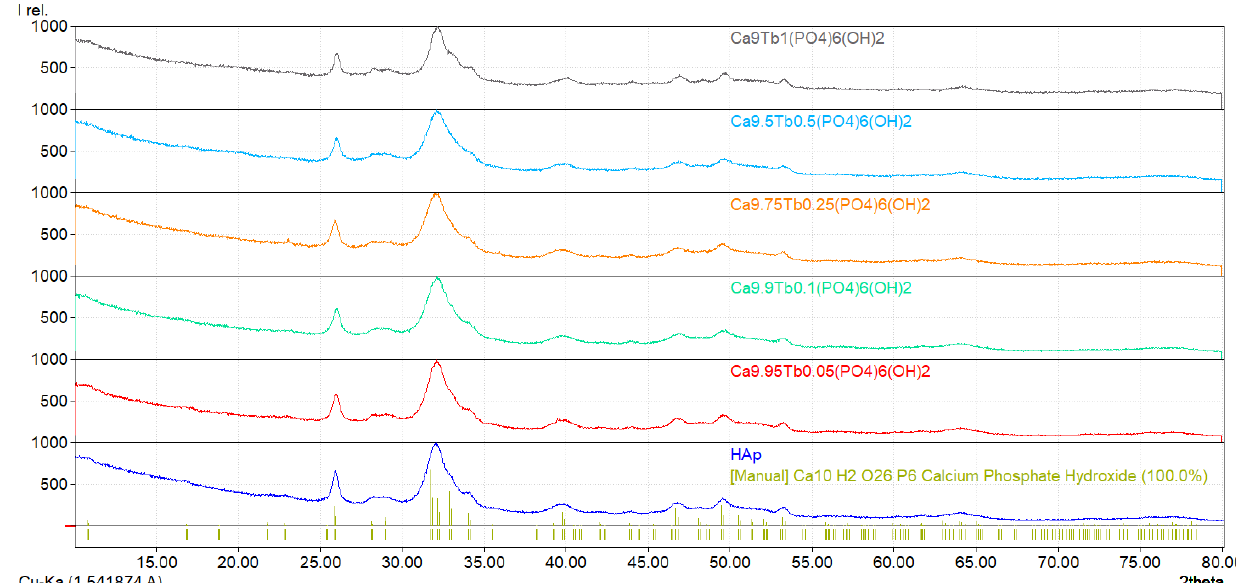
Figure 2. X-ray diffraction patterns of hydroxyapatite (HAp) and Ca 10 − x Tb x (PO 4 ) 6 (OH) 2 powders. Table 2. Calculated crystallite size (D) values and degree of crystallinity ( χ c ) of pure HAp and terbium-doped hydroxyapatite with various